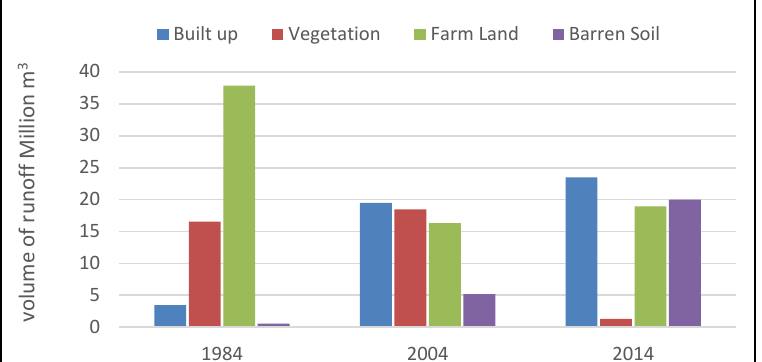
Figure 10. Volume of runoff across different land use/land cover types.